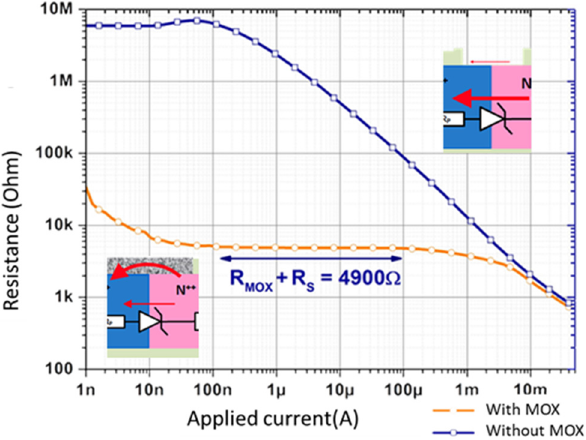
Figure 10. Characterization of the sensing diode with and without MOX layer.